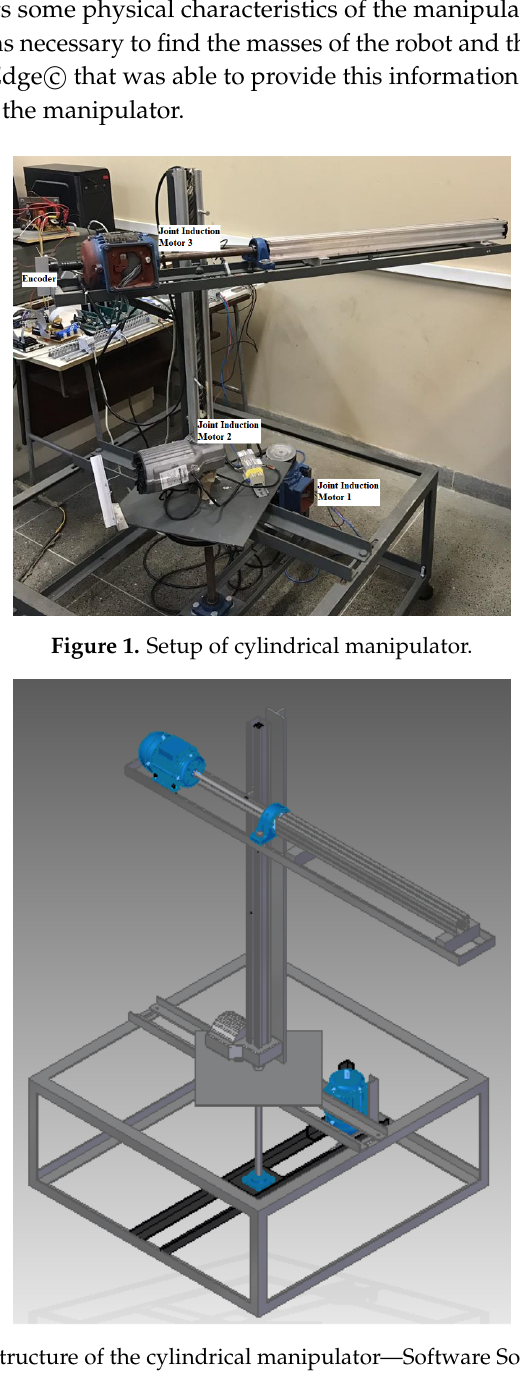
Figure 2. Structure of the cylindrical manipulator—Software Solid Edge c (cid:13)